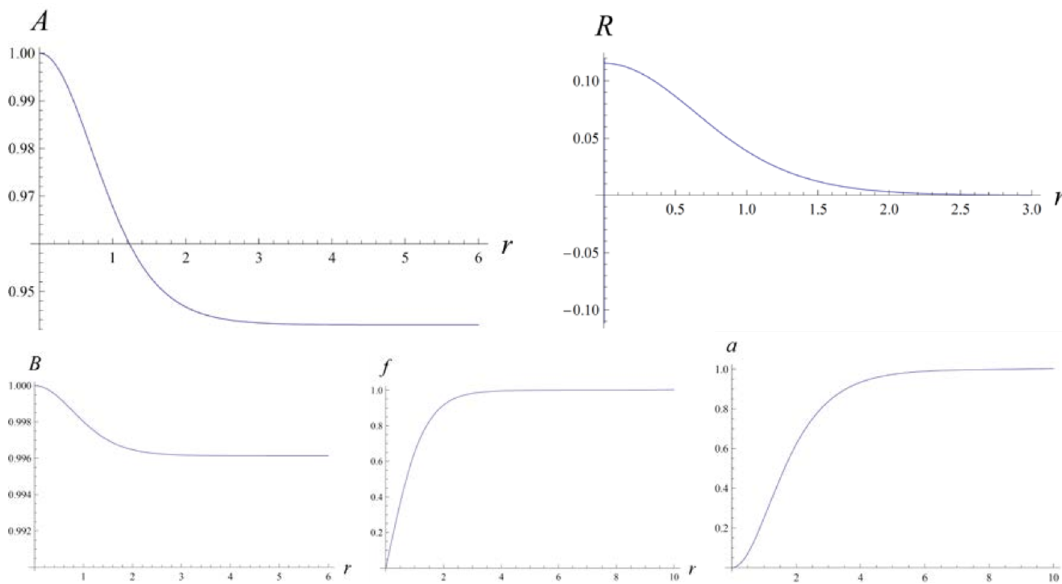
JHEP01(2021)166